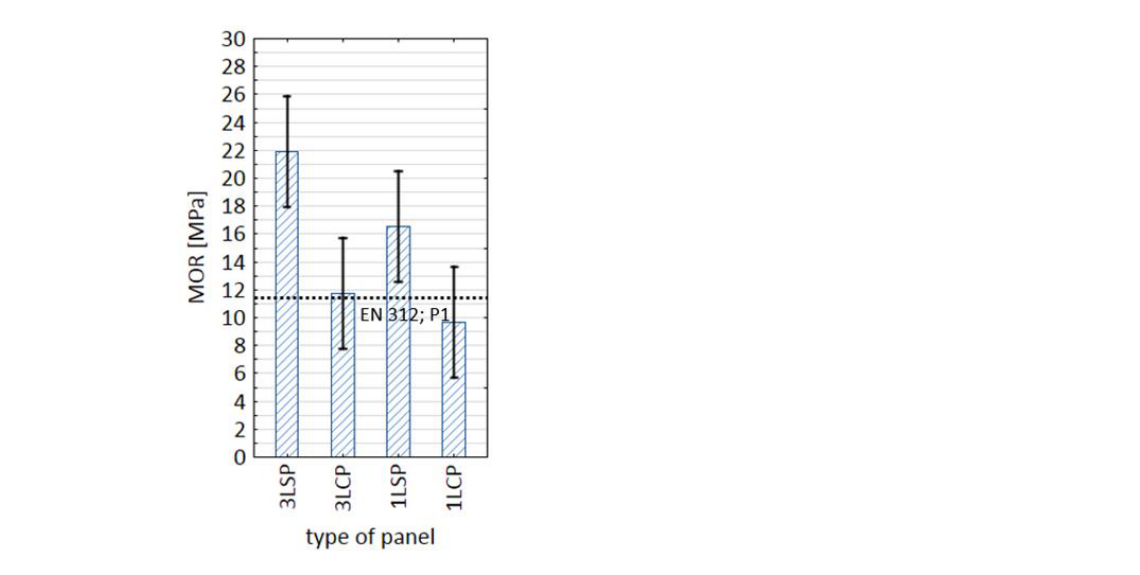
Figure 8. Modulus of rupture (MOR) of measured particleboards (PBs). 3LCP—three-layer cup-plant PB, 3LSP—three-layer spruce PB, 1LCP—single-layer cup-plant PB, and 1LSP—single-layer spruce PB ( n = 10).